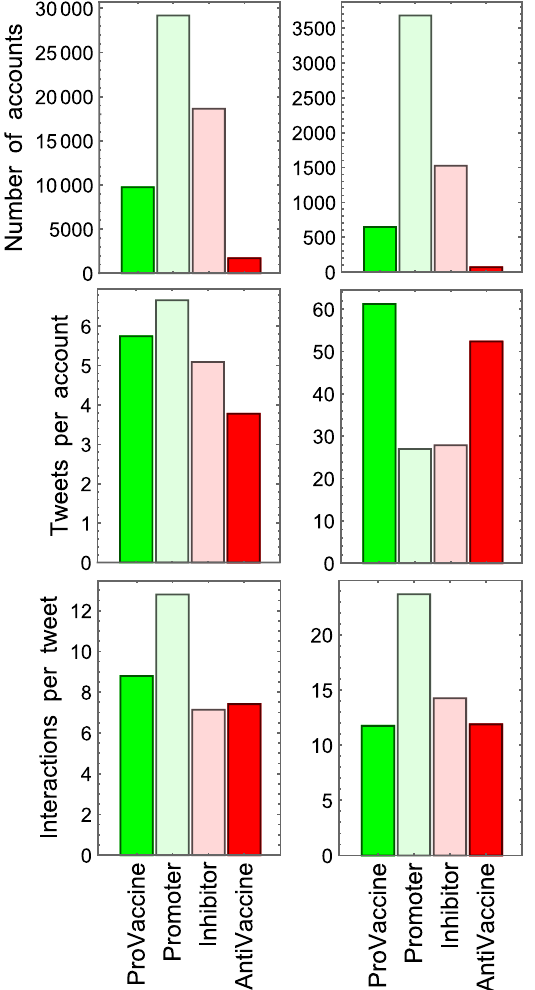
Figure 2. Accounts and activity per category. Bar charts of the number of accounts, mean number of tweets per account, and mean number of interactions per tweet for the four account categories (pro-vaccine, promoter, inhibitor, anti-vaccine), averaged either over all accounts (left column) or over the top 10% with most interactions (right column). Promoter accounts appear as the largest category, followed by inhibitors. The top 10% pro/anti-vaccine activist accounts tweet significantly more than the moderates. Despite their smaller number and lack of centralized organization, anti-vaccine accounts generate significant